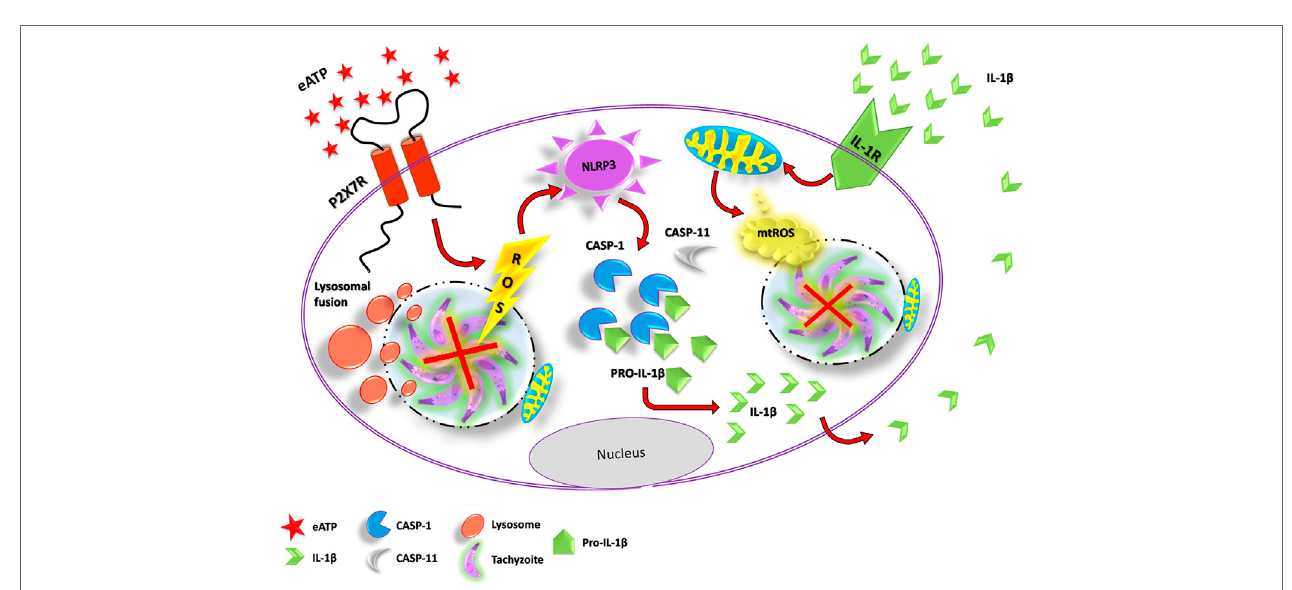
FigUre 7 | Proposed mechanism of T. gondi infection control mediated by extracellular ATP (eATP)/P2X7 receptor and IL-1 β , in macrophages. Binding of eATP to the P2X7 receptor may lead to pathogen elimination via different mechanisms: the fusion of lysosomes to the parasitophorous vacuole (forming a phagolysosome), reactive oxygen species (ROS) generation and the activation of the canonical NLRP3 inflammasome. NLRP3 inflammasome activation by eATP potentiates IL-1 β release through caspase-1 activity and, in turn, IL-1 β in the extracellular compartment binds to its receptor, triggering T. gondii elimination via mitochondrial ROS